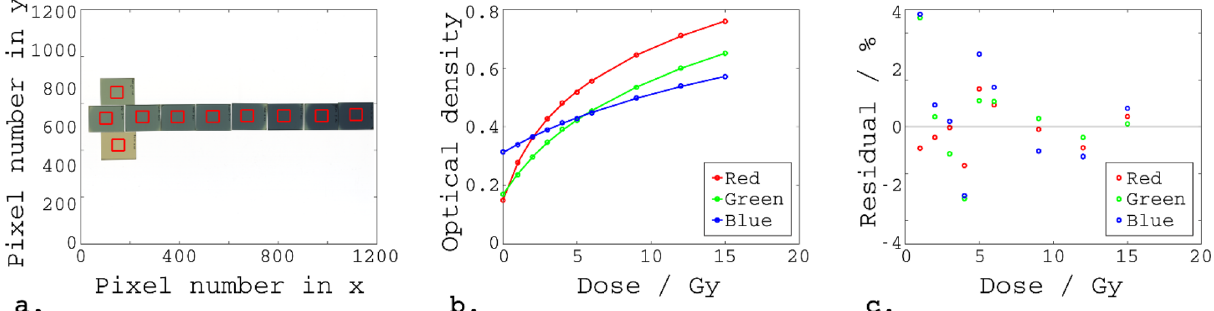
Figure 4. Calibration of the Gafchromic EBT3 film. ( a ) The calibration films. For each film, the median optical density within the region-of-interest marked by the red box was used for creation of the calibration curves. ( b ) The calibration curves, relating optical density and dose for each colour channel. The circles represent the median measured optical densities, and the lines represent the fits of the form: Dose = A × B O.D. + C. ( c ) The residuals for each colour